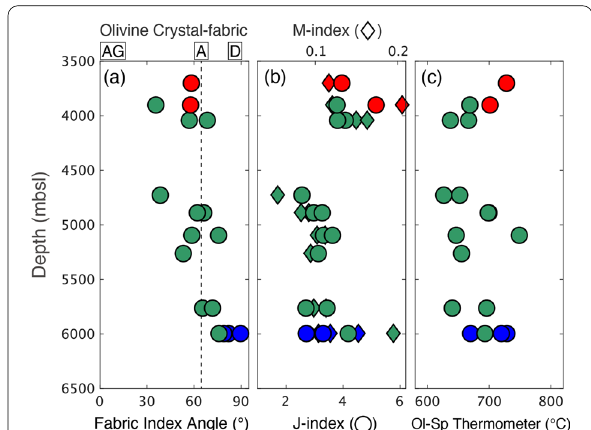
Fig. 10 Spatial trends in olivine crystal‑fabric type, crystal‑fabric intensity and estimated temperature for the 139°E Ridge along the Shinkai 6500 dive track. Red symbols indicate coarse‑grained samples, green symbols indicate samples with heterogeneous textures, and blue symbols indicate fine‑grained samples. a FIA vs. depth. AG: AG